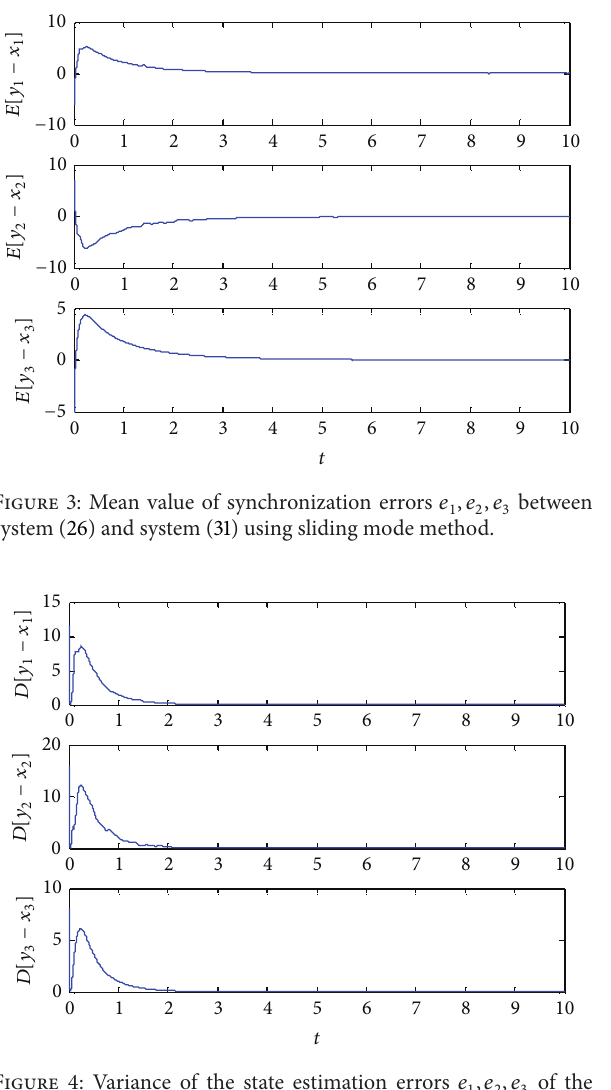
Figure 4: Variance of the state estimation errors 𝑒 1 , 𝑒 2 , 𝑒 3 of the system (26) and system (31) using the sliding mode